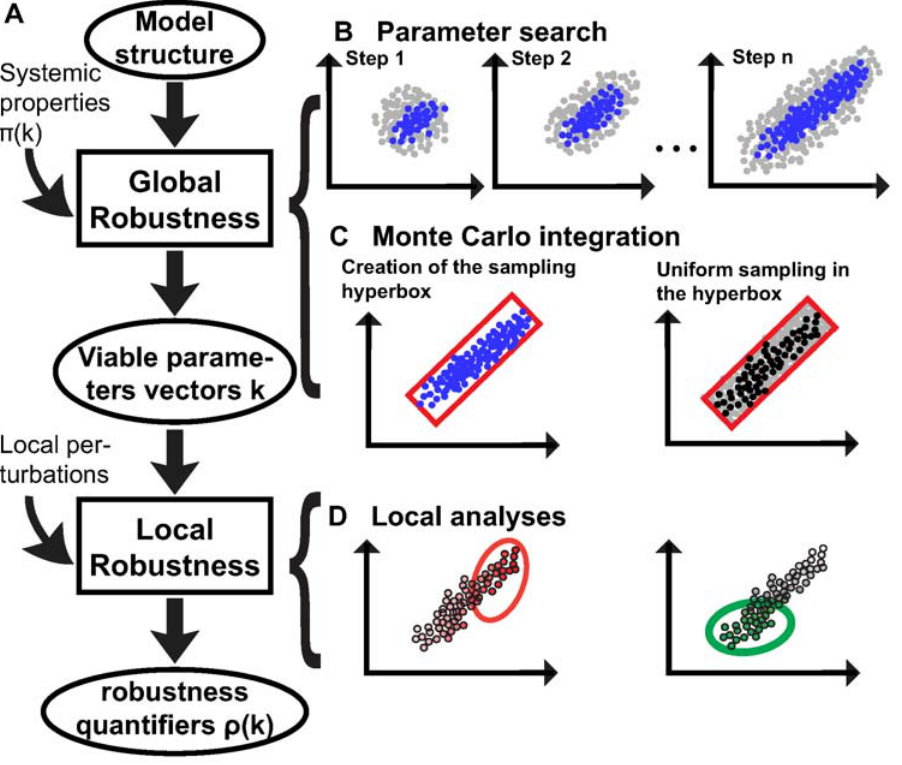
Figure 1. Glocal robustness analysis flow for a hypothetical two dimensional parameter space. (A) A model structure and systemic properties serve as inputs for the global step of the analysis. This global analysis is composed of (B) and (C) and yields viable parameter vectors k for the model in addition to the normalized viable volume R . Different local perturbations are applied to these parameter vectors (D) in order to quantify their local robustness r ( k ) . (B) Monte Carlo sampling to define viable parameter ranges. The first sampling step uses Gaussian random sampling with independently and identically distributed random variables. Some of the tested parameter vectors (gray circles) are viable (blue circles). For subsequent iterative steps, sampling occurs according to the covariance matrix of viable parameters estimated in previous steps. (C) Monte Carlo integration. To estimate the volume in which viable parameter sets occur, we define a hyperbox (red rectangle in left panel) that contains all the viable parameters of the last iteration. We then sample uniformly parameter vectors from this box (right panel, gray circles) and estimate the fraction of viable parameter vectors (right panel, black circles). (D) Local analyses are performed on all viable parameter vectors and help identify correlations between parameter vectors or their components, and robustness values (color intensity) to provide regions of high robustness in the parameters space; two different local robustness quantifiers (left-red, and right-green).